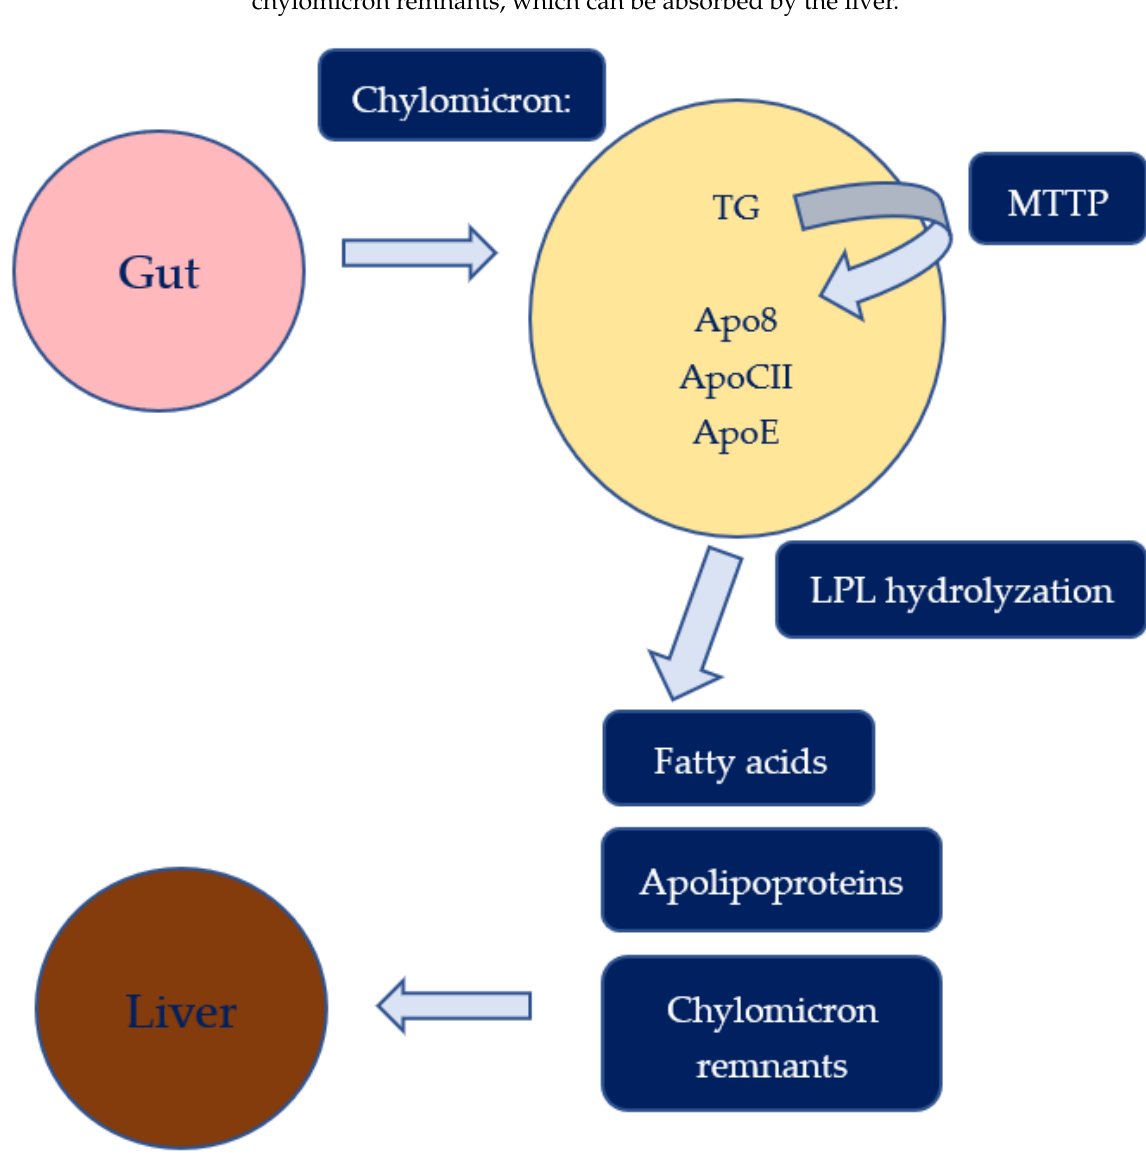
Figure 1. Exogenous pathway of lipid metabolism. Triglycerides (TG), lipoprotein lipase (LPL), microsomal triglyceride transfer protein